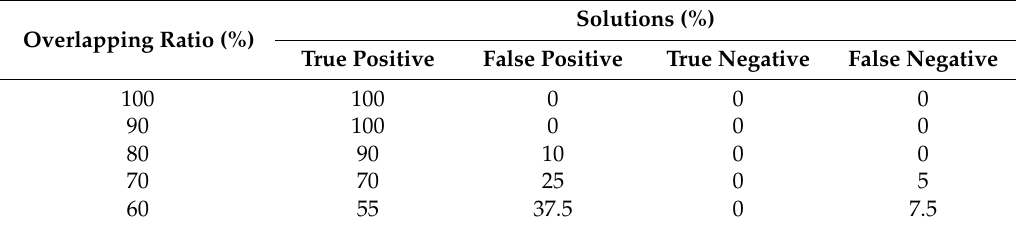
Table 1. Solutions that were generated by the standard algorithm.